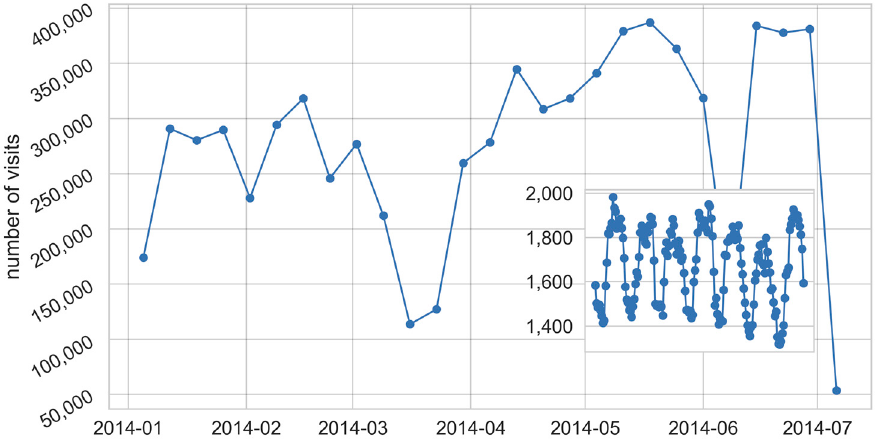
Figure 3. Number of visits during 7 months of mobility for ParticipAct data set. The graph reports the time periods with high and low numbers of visits. The inset graph shows a typical pattern of visits for a representative visits for a representative week.